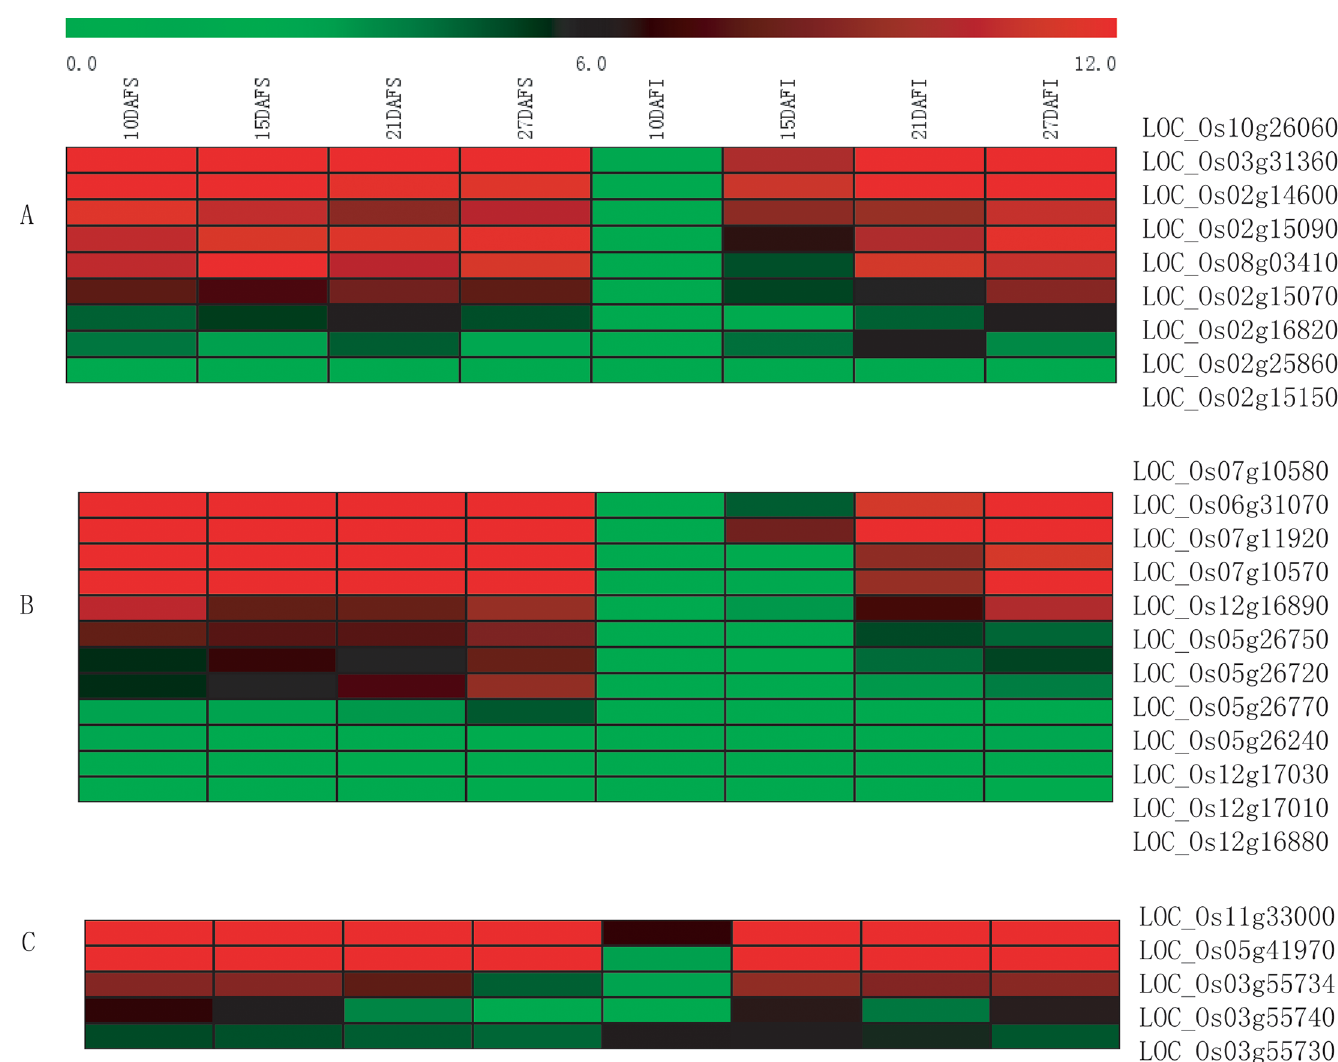
Fig 5. Heat map representation of seed storage protein genes expression. “ A ” indicates glutelin genes, “ B ” indicates prolamin genes, and “ C ” indicates albumin genes. “ DAF ” indicates day after flowering. “ S ” indicates superior grains, and “ I ” indicates inferior grains. Expression of genes (in TPM) was subjected to log2 conversion. With those zero expression genes, zero was converted with 0.01(in